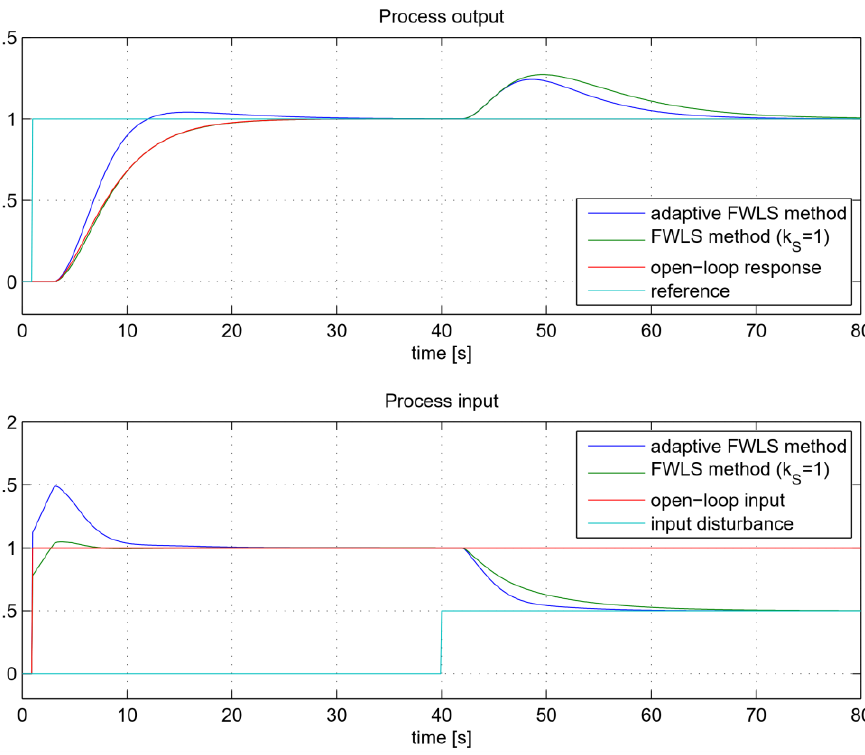
Figure 19. The closed-loop tracking and control signals for process G P 3 .